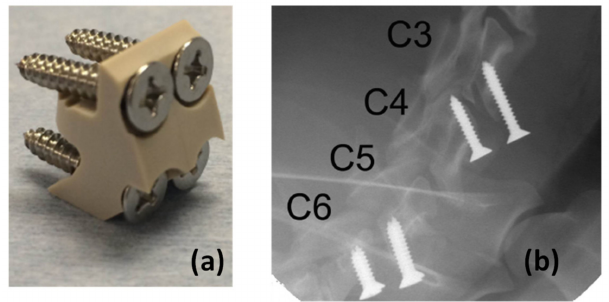
Figure 6. ( a ) Interbody spacer device and ( b ) postsurgical X-ray examination. Reproduced with permission from [48]. Copyright 2017, PLoS ONE.